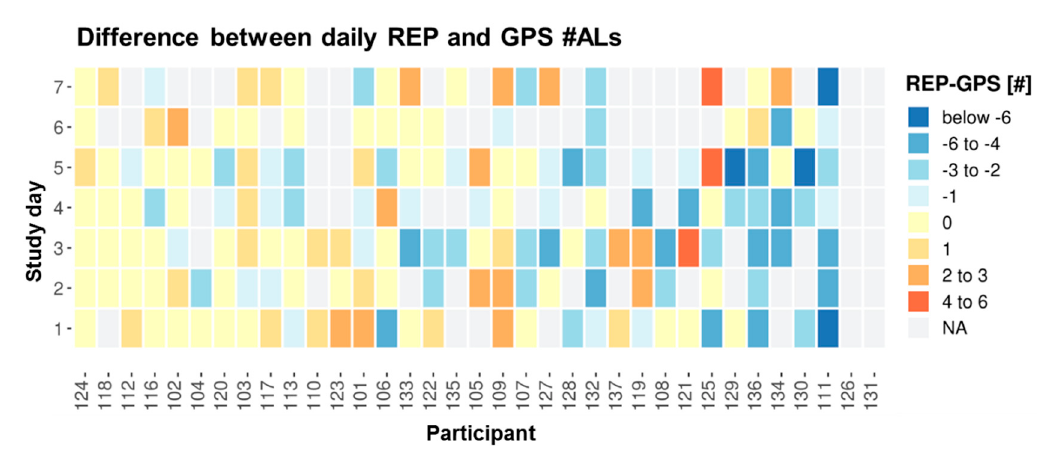
Figure 12. Daily di ff erence between REP and GPS #ALs by participant and study day: Yellow = agreement, blue shades = REP < GPS, red shades = REP > GPS, grey = invalid days, all grey = invalid participants ( #126, 131 ). Participants are ordered according to increasing average absolute deviation per participant (ignoring NAs). Participants are represented by their unique user IDs.